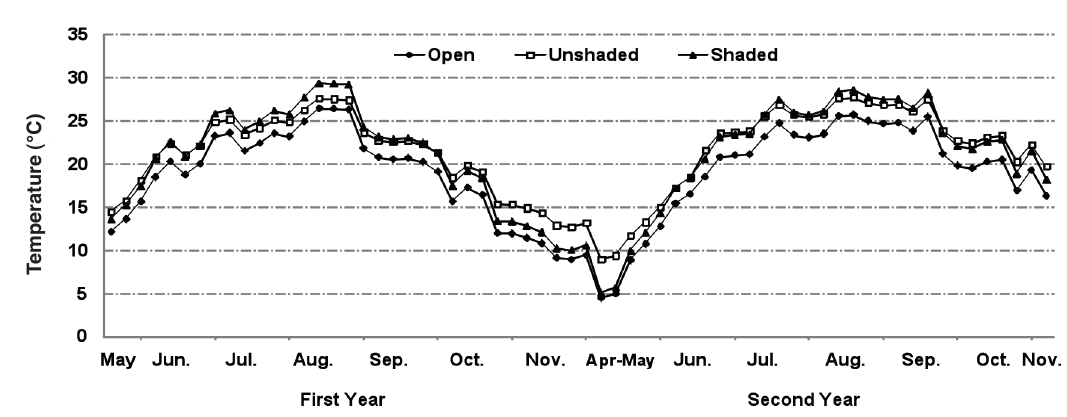
Fig. 1: The temperature data of nursery conditions with respect to